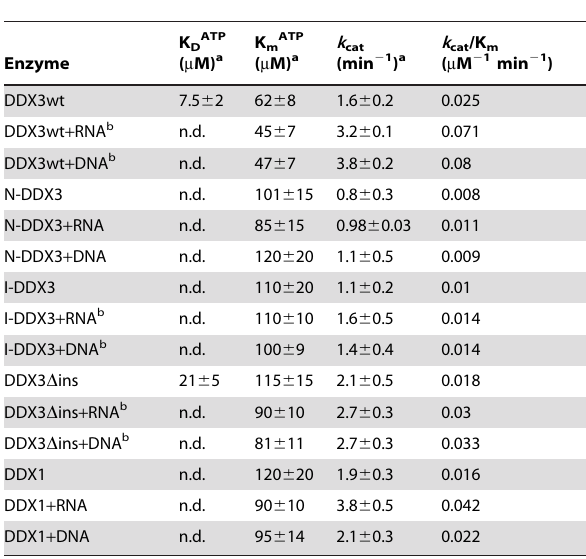
Table 1. ATPase reaction efficiency of DDX3wt and mutants and DDX1 in the absence or presence of nucleic acids.